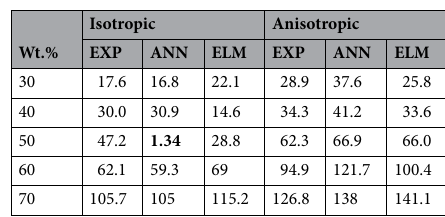
Table 10. The comparison of relative MR effect between experiment and proposed models.